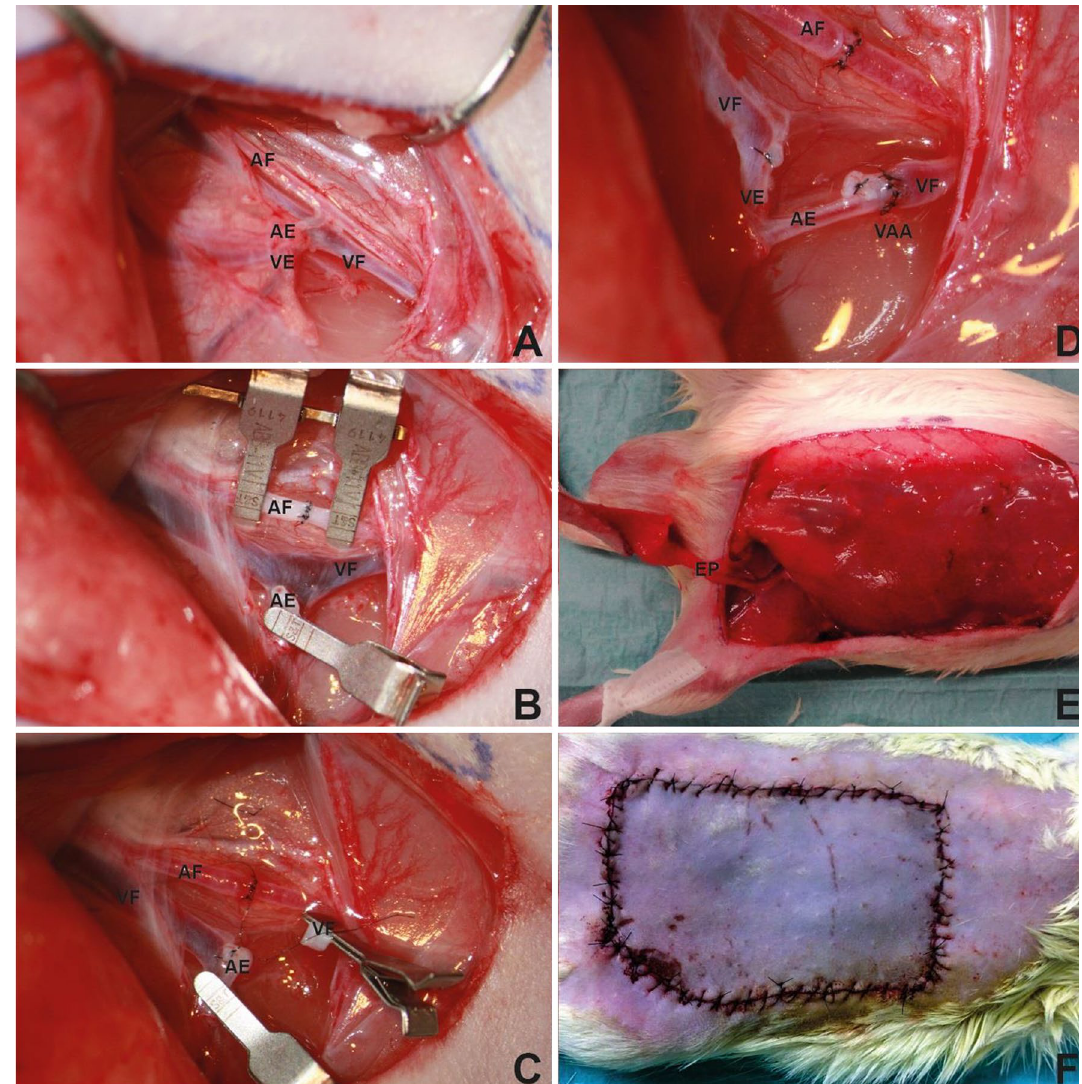
Figure 2. Clinical situation of the surgical procedure. ( A ) Femoral artery and vein with the epigastric branches. ( B ) Dissected epigastric vessels with its femoral origin and re-anastomosed femoral artery. ( C ) The re-perfused femoral artery, ligated branch of the proximal femoral vein, and first stitch in the distal femoral vein. ( D ) Anastomosis between the distal femoral vein and the epigastric artery. The distal femoral vein shows an arterial red color that can be explained by the retrograde arterial inflow from the mammarian artery. ( E ) Raised flap that is now perfused only by the epigastric vessels. ( F ) Flap sutured back into the wound bed in group III (+ 14 d). The flap appears slightly livid compared with the surrounding tissue. AF—arteria femoralis; AE—arteria epigastrica; EP—epigastric pedicle; VF—vena femoralis; VE—vena epigastrica; VAA—veno-arterial